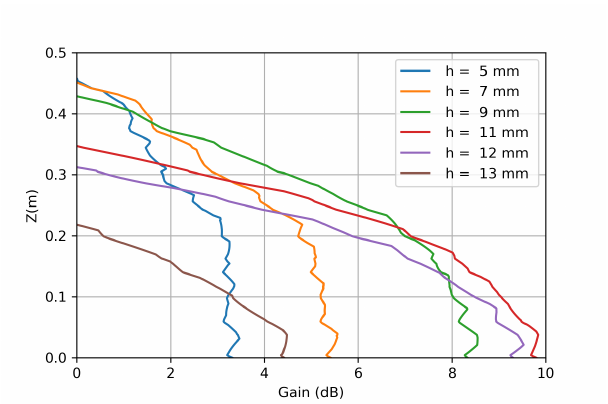
FIGURE 7. Simulated vertical gain versus substrate thickness along a line lying in the vertical plane at X = 59 cm from the monopole